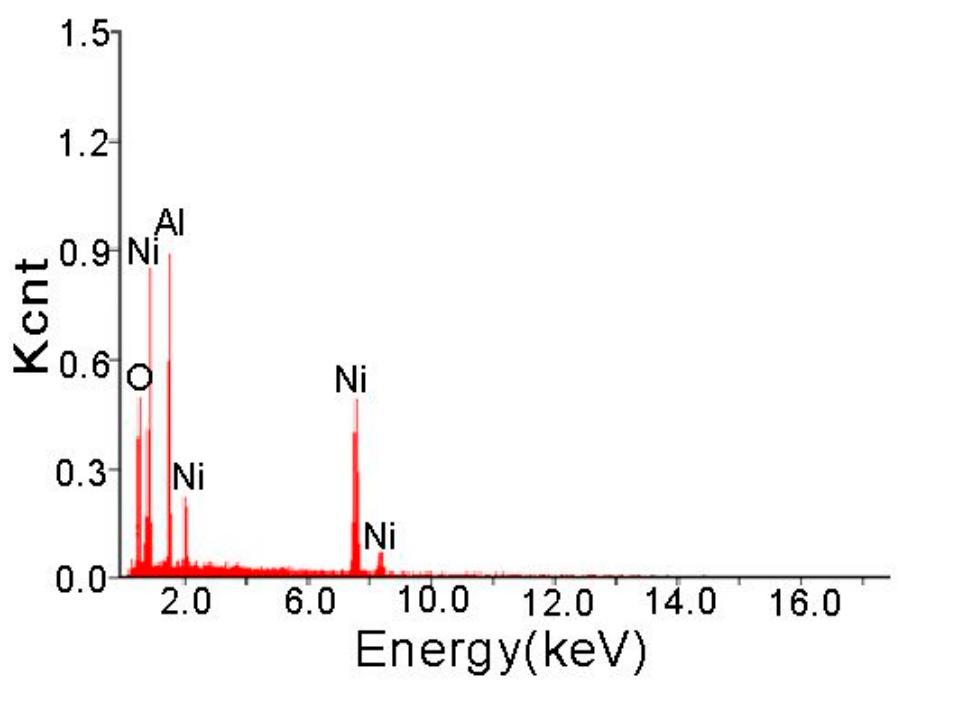
Figure 3. EDX spectrum of the Ni/n–Al 2 O 3 layer.